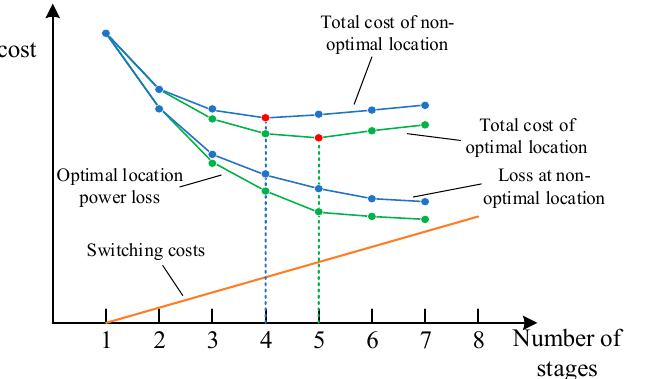
Figure 1. Optimal number of segments is affected by whether the switch position is optimal or not.